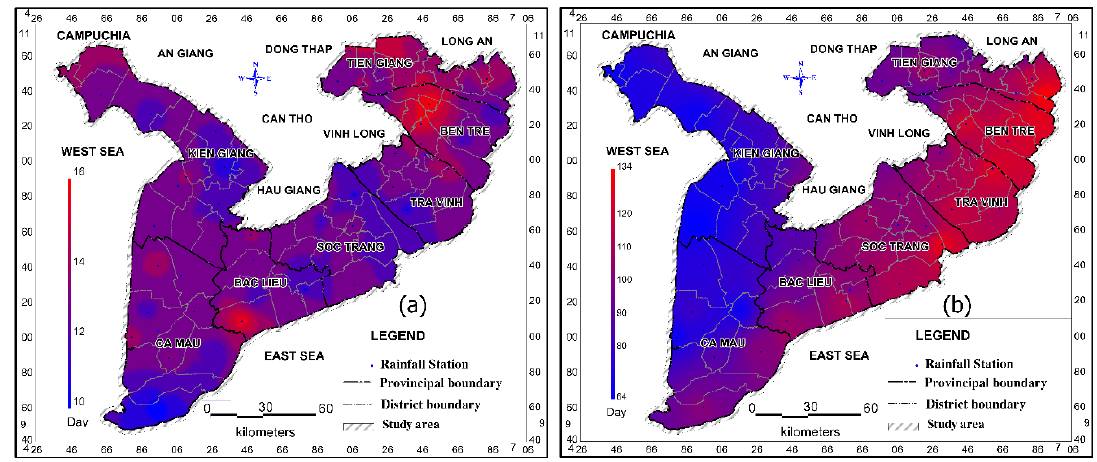
16 of 26 Figure 9. Relation between rainfall and ONI: ( a ) annual rainfall and annual average ONI and ( b )